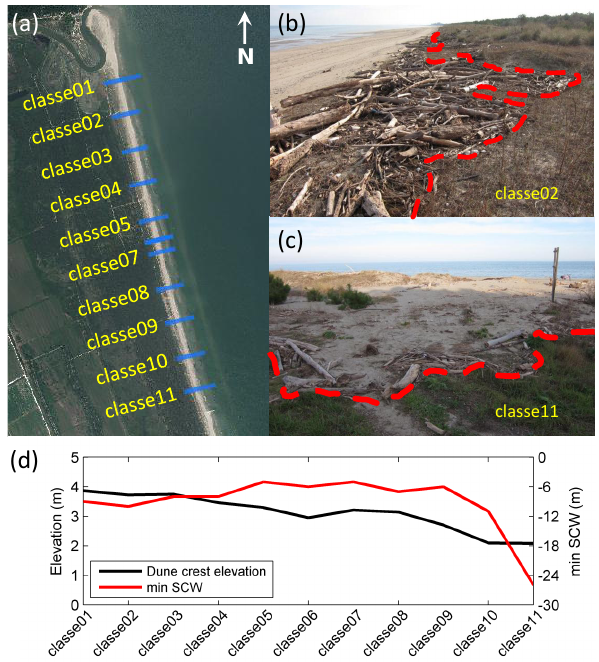
Figure 4. The Lido di Classe validation site. (a) Locations of all 11 profiles that are regularly monitored using RTK-GPS. (b) Profile line classe02 after the Halloween storm. (c) Profile line classe11 after the Halloween storm, indicating an overwash fan (Photos: Mitchell Harley). (d) The relationship between dune crest eleva- tion and the minimum safe corridor width (SCW) measured after the